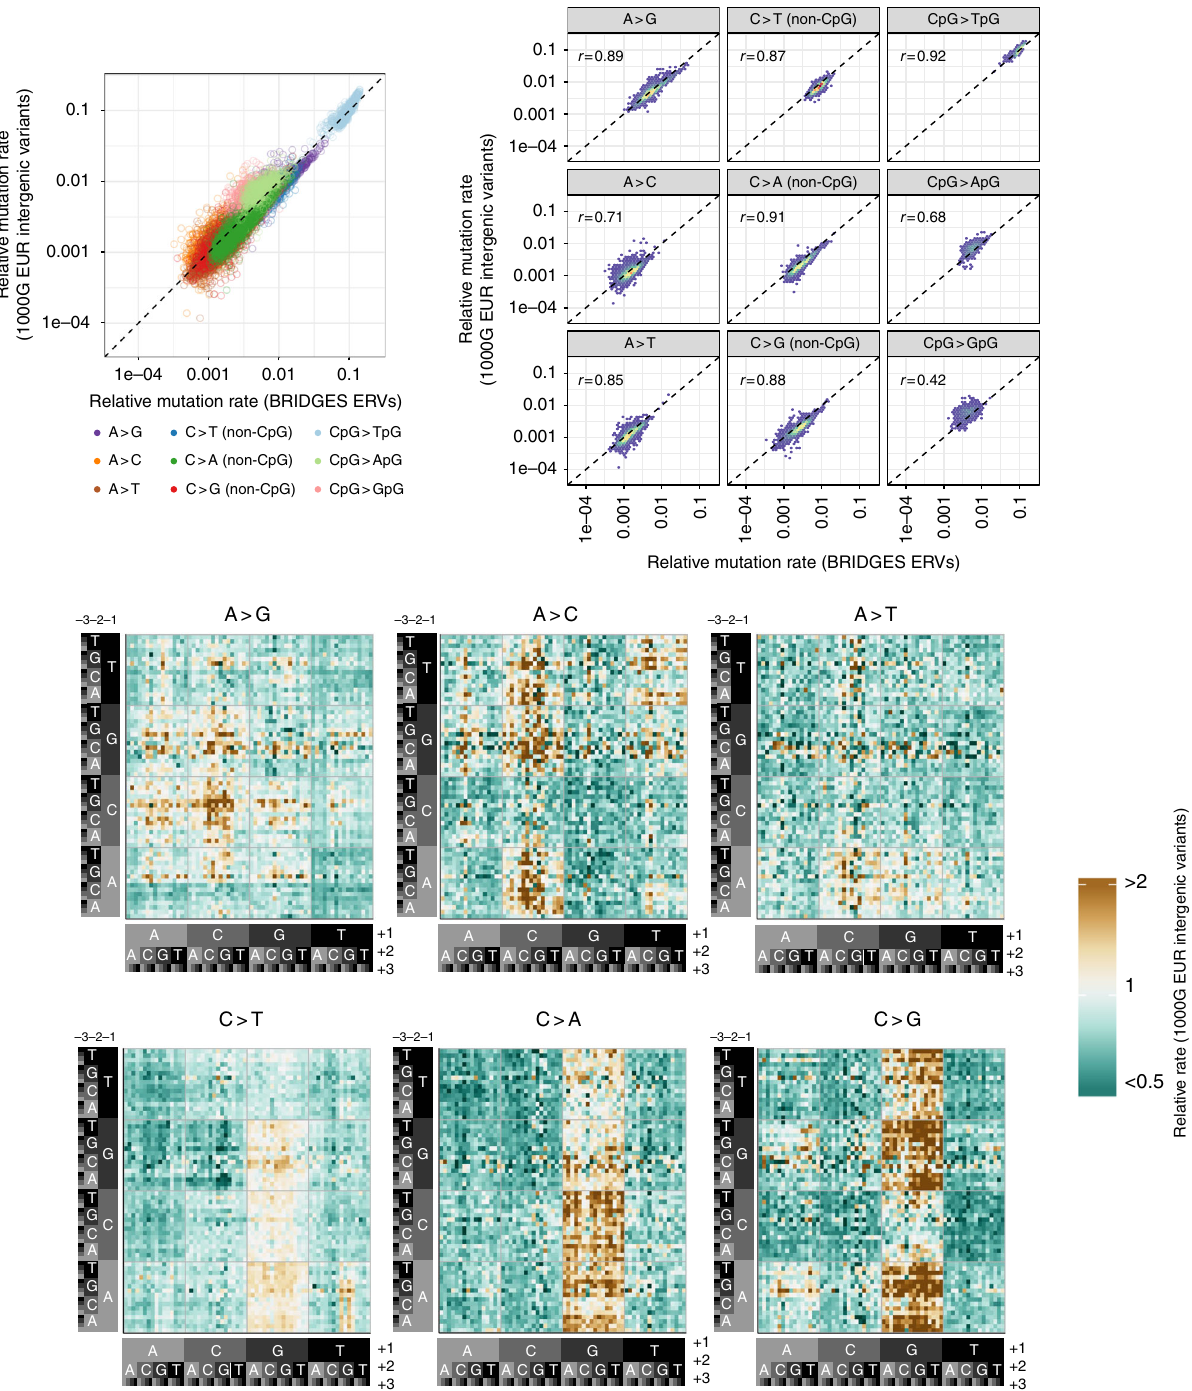
Fig. 2 Discordance between ERV-estimated and common SNV-estimated mutation rates. a Relationship between 7-mer relative mutation rates estimated among BRIDGES ERVs ( x -axis) and the 1000G intergenic SNVs ( y -axis) on a log-log scale. We note that the strength of this correlation is driven by hypermutable CpG > TpG transitions. b Type-speci fi c 2D-density plots, as situated in the scatterplot of a . The dashed line indicates the expected relationship if no bias is present. c Heatmap showing ratio between the relative mutation rates for each 7-mer mutation subtype. Subtypes with higher rates among the 1000G SNVs (relative to ERV-derived rates) are shaded gold, and subtypes with lower rates in the 1000G SNVs are shaded green. Relative differences are truncated at 2 and 0.5, as only 2.5% of subtypes showed differences beyond this range mutations, the masked rates produced a worse fi t than the determine if the same trend of improved goodness-of- fi t using unmasked rates (Table 1), suggesting that the reduction in ERVs longer K-mers held for different mutation types. In each of these caused by applying the mask has a larger effect on the precision of type-speci fi c validation models, the ERV-based 7-mer relative our estimates than any mapping artifacts present in the unmasked mutation rate estimates provided a signi fi cantly better fi t than data. We next analyzed each mutation type separately to estimates in smaller K-mers (Supplementary Table 5). NATURE COMMUNICATIONS| (2018) 9:3753 |DOI: